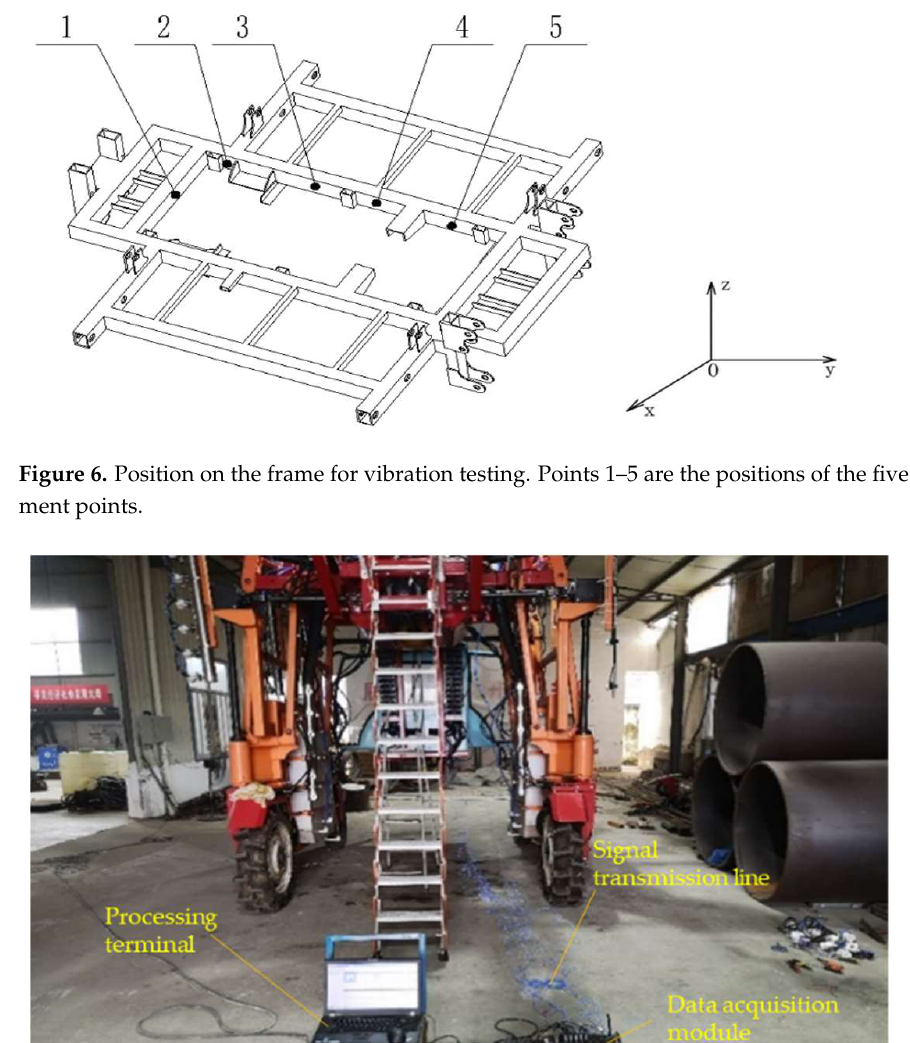
Figure 6. Position on the frame for vibration testing. Points 1–5 are the positions of the five meas- urement points. Table 3. Performance parameters of vibration test instruments.